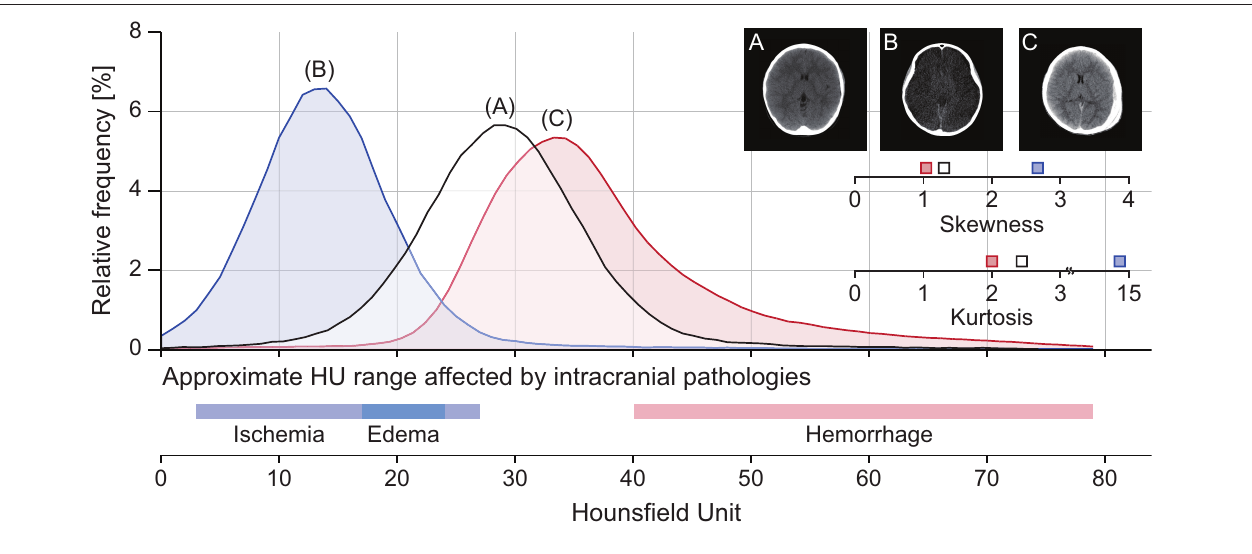
FIGURE 2 | Representative cases of intracranial densitometry affected by various TBI pathologies. (A) A 7-year-old male patient with no visible pathology, (B) A 10-year-old female patient with massive brain edema, (C) A 7-year-old male patient with acute subdural hemorrhage. The color bar at the bottom shows the HU range on densitometry, which mainly affects intracranial